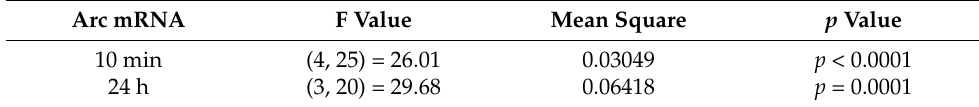
Figure 2. Effect of ketamine on Arc mRNA. ( A ) The Arc mRNA expression levels after 10 min. ( B ) The Arc mRNA expression levels after 24 h. Data are expressed as means ± SD. * p < 0.05 and ** p < 0.01 versus CG. Table 3. Table for ANOVA results for Arc mRNA data.